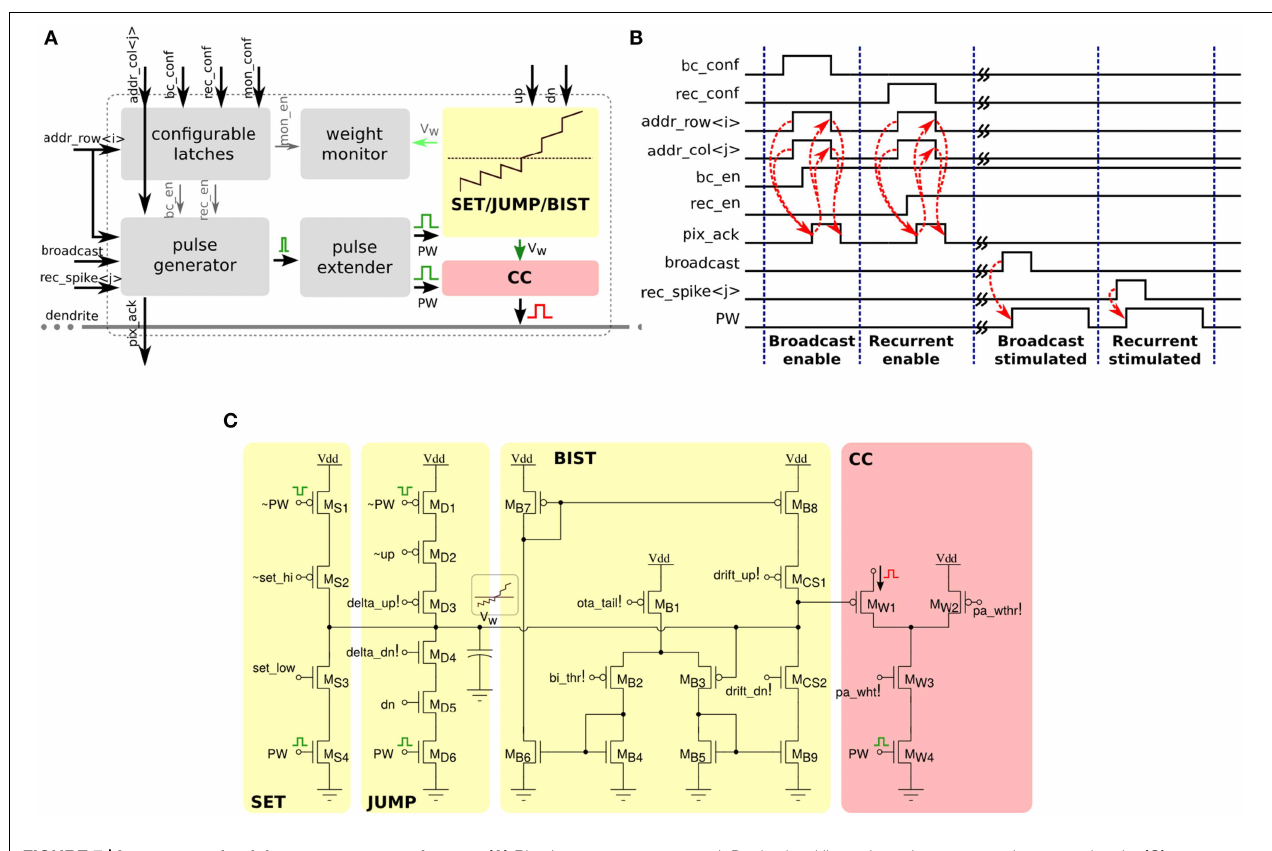
FIGURE 7 | Long-term plasticity synapse array element. (A) Plastic synapse configuration logic block diagram. (B) Timing diagram for broadcast and recurrent activation modes in one synapse using 4-phase handshaking